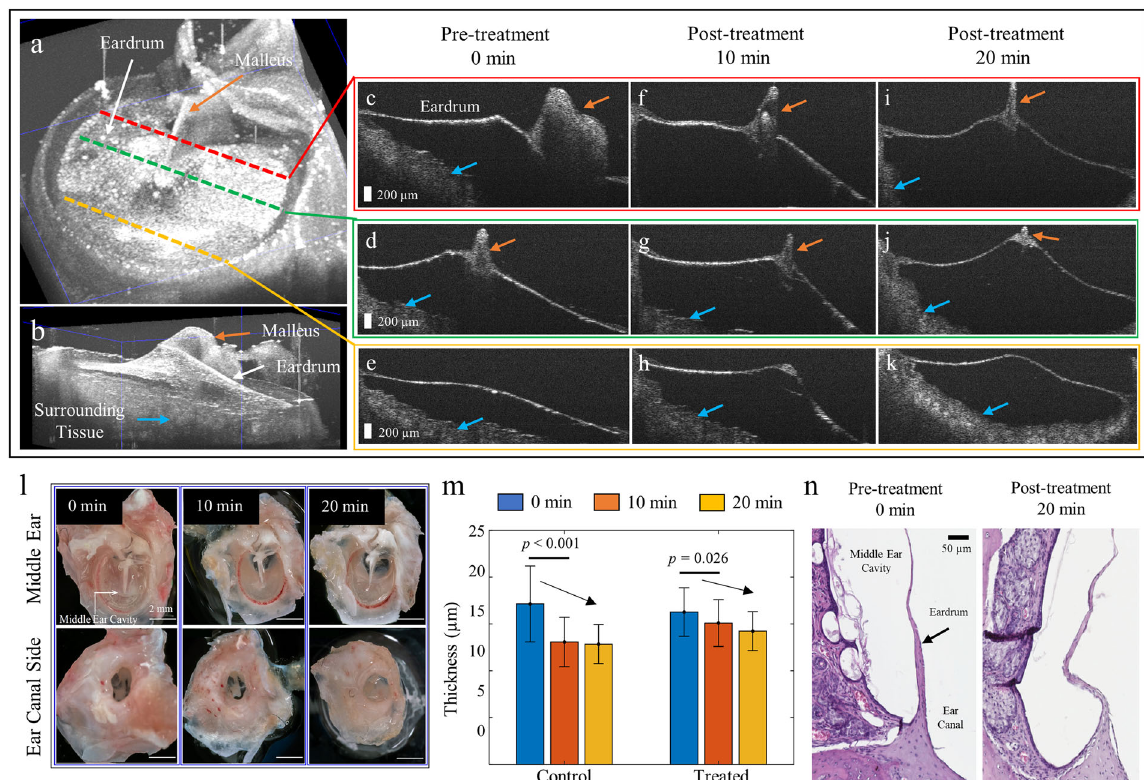
Fig. 3 OCT and histology of the extracted rat eardrum after microplasma exposure. a, b A 3D reconstructed en face and cross-sectional OCT view of the excised rat eardrum. The malleus (orange arrows) attached to the eardrum is visualized. Representative cross-sectional OCT images after c – e 0 min (pre-treatment), f – h 10 min, and i – k 20 min of microplasma jet array treatments at different cross-sections. Note that the surrounding ear canal tissue (blue arrows) was captured in OCT due to the tortuous and narrow ear canal of the rat. Scale bar represents 200 µm. l Photos of the rat eardrum after microplasma exposure. Scale bar indicates 2 mm. m Plot of eardrum thickness determined from OCT with increasing duration for the rat eardrum left in air (control) and the rat eardrum exposed to microplasma (treated). The error bars denote standard deviations from different cross-sectional images. n Histologic images of the rat eardrum after 0 min (the pre-treatment) and 20 min of microplasma exposure. Scale bar represents 50 P. aeruginosa suspension. Figure 4e shows that same membrane after incubating for four days at 37 °C. Note the appearance of a yellow P. aeruginosa bio fi lm at the center of the membrane (denoted by the dashed red lines), formed as a result of trapping the bacterial suspension in the well of the plate. The edge of the membrane and coverslip at the bottom are indicated by yellow and blue dashed lines, respectively. To validate and assess the presence and structure of the bio fi lm, the membrane of Fig. 4 was examined by a scanning electron microscope (SEM) and several representative micrographs are presented in Fig. 5a. Two different morphologies were observed from the top of the membrane (Fig. 5a – c, green box): the fi rst in